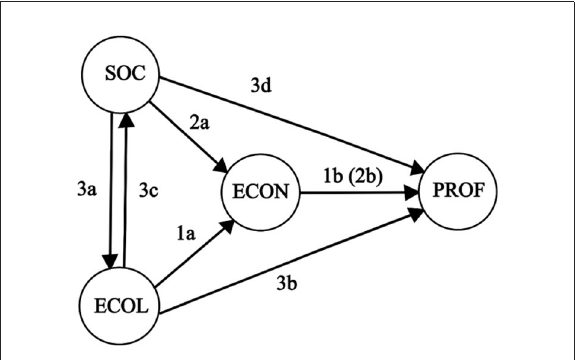
FIGURE1 Proposed conceptual framework. ECON: economic, ECOL: ecological, SOC: social and PROF: profitability. The numbers (e.g., 1a, 1b, 2a, 2b, 3a, 3b, 3c and 3d) represent the different SD paths based on McKenzie